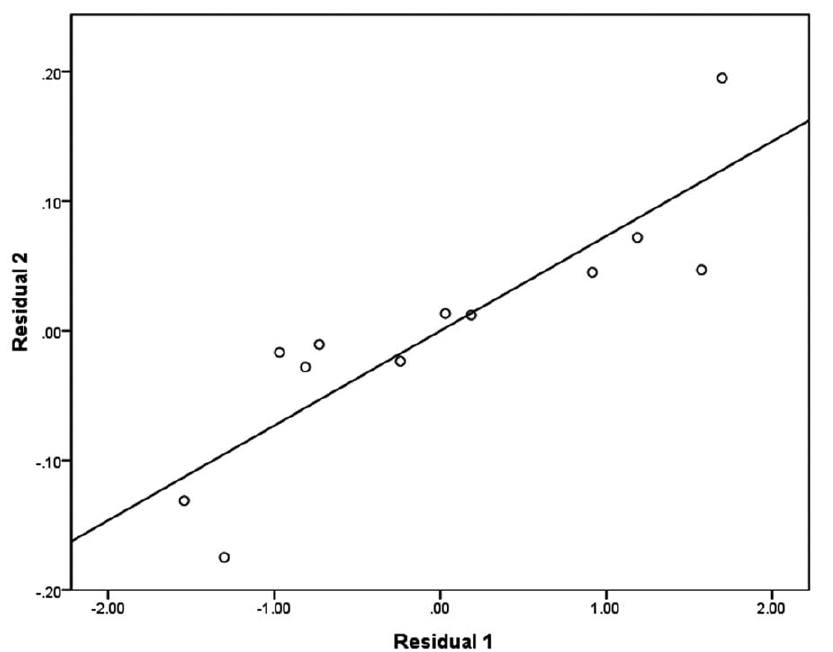
Figure 2. Scatter plot of two residuals. It showed that the cortical thickness is increased associated with more years of training ( r =0.87; p =0.0001). Residual 1: residuals were obtained from regression of training against age and education. Residual 2: residuals were obtained from regression of cortical thickness against age and education.